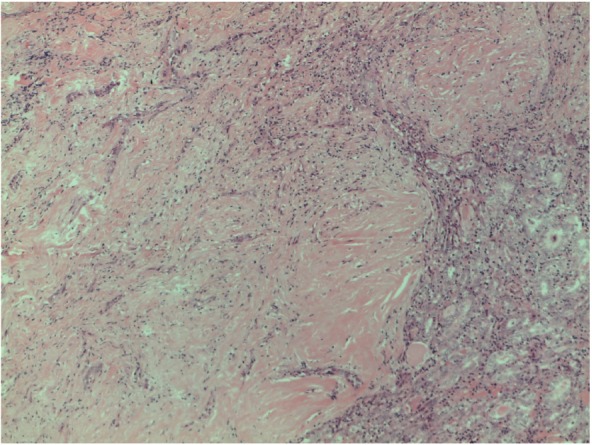
Papillary carcinoma sclerosing variant x200 magnification.